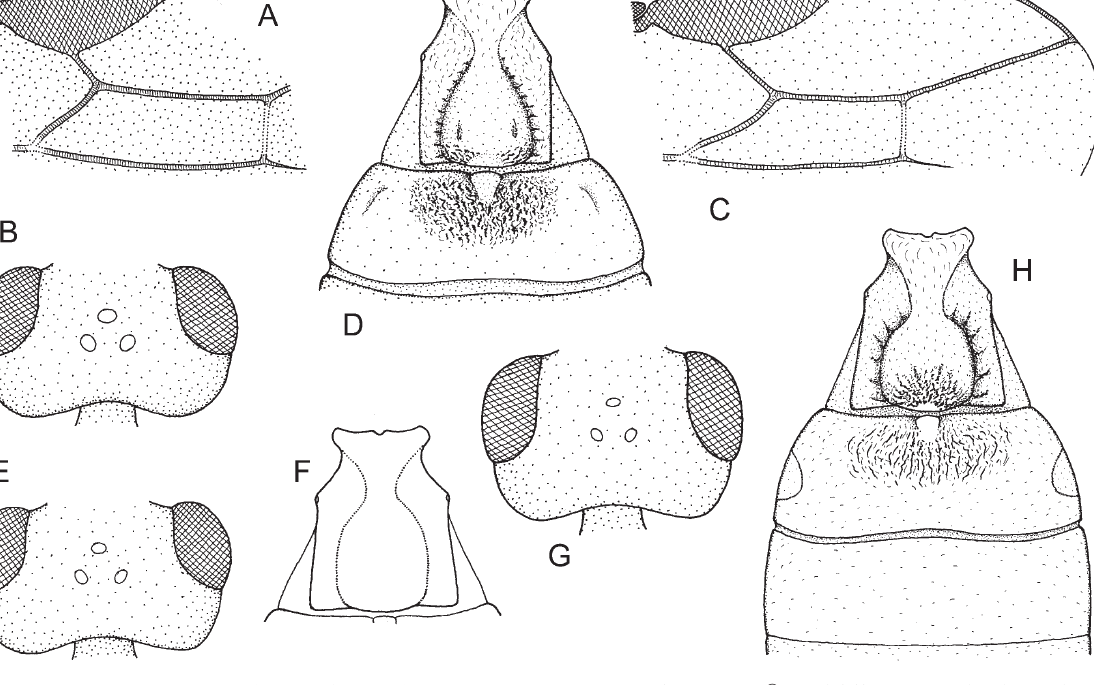
Fig. 23. — A . Bracon ( Foveobracon ) megapterus Wesmael, 1838, ♀, middle part of